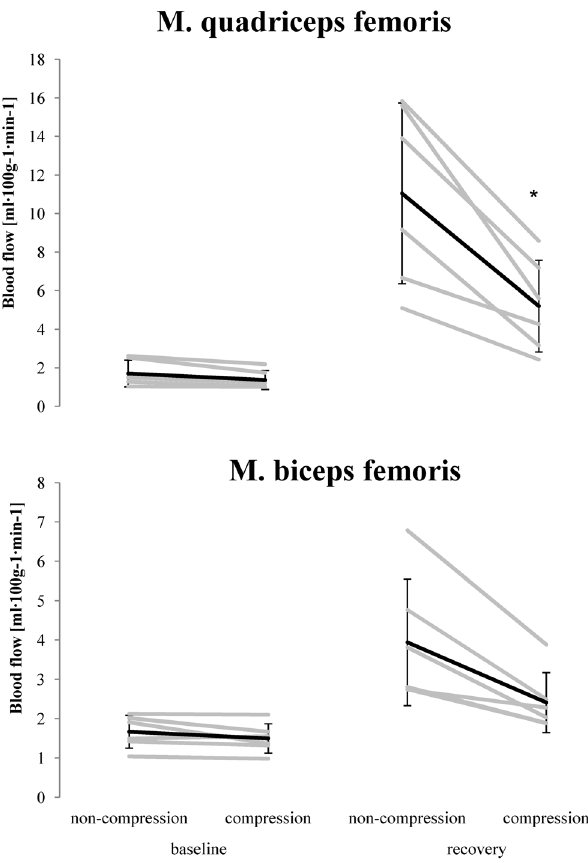
Figure 3. Skeletal muscle blood flow. M. quadriceps femoris (above) and m. biceps femoris (below) without (non-compression) and with compression (compression) during baseline and recovery from high intensity exercise (*indicates statistical significant differences P , 0.05).